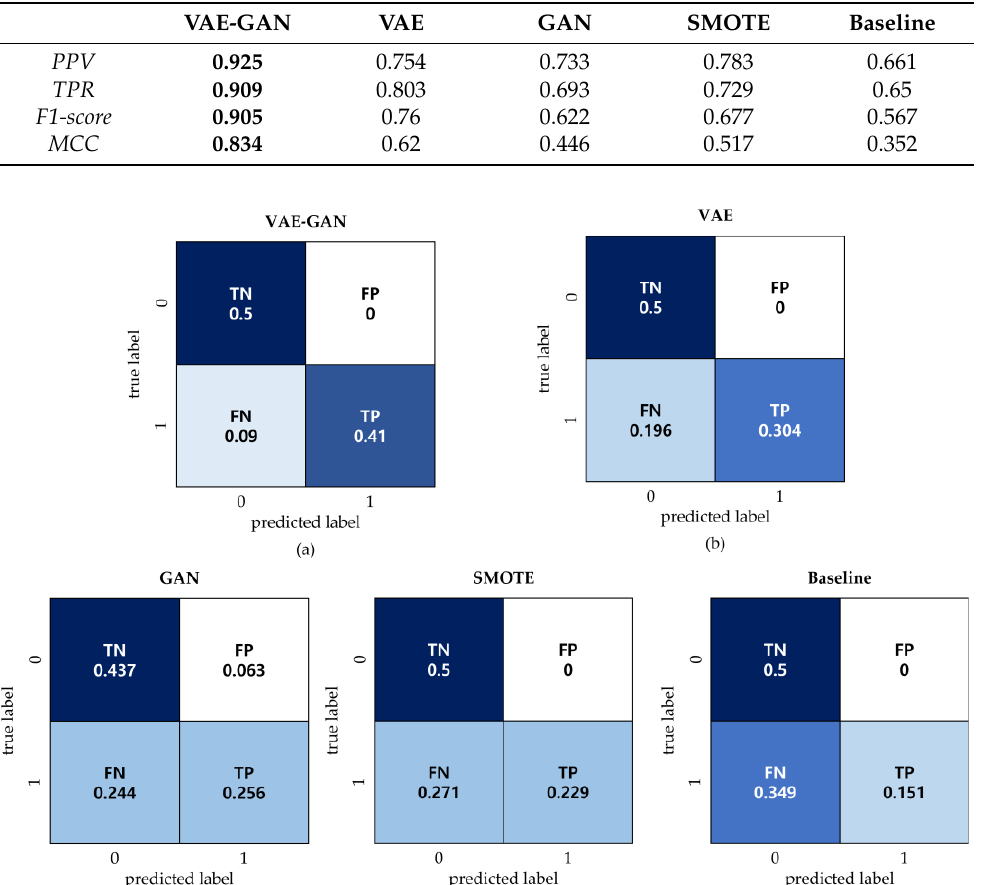
Table 5. Classification performance metrics on proposed and conventional models.